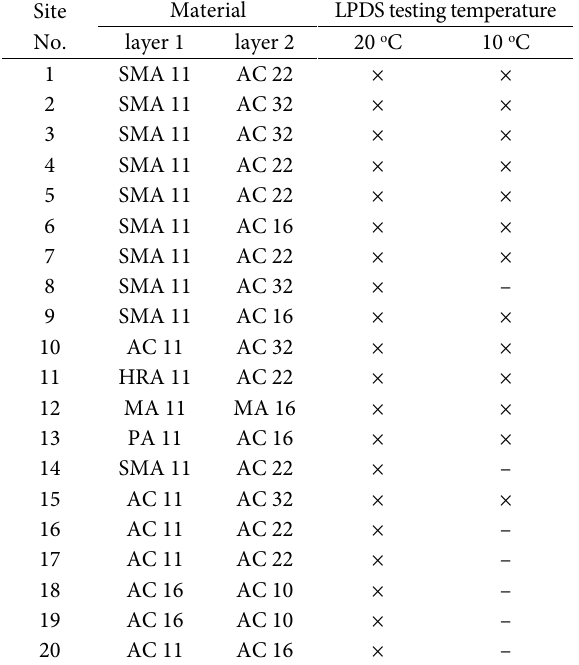
Fig. 3. Location of Swiss test sites (Raab, Partl 1999) Table 2. New road